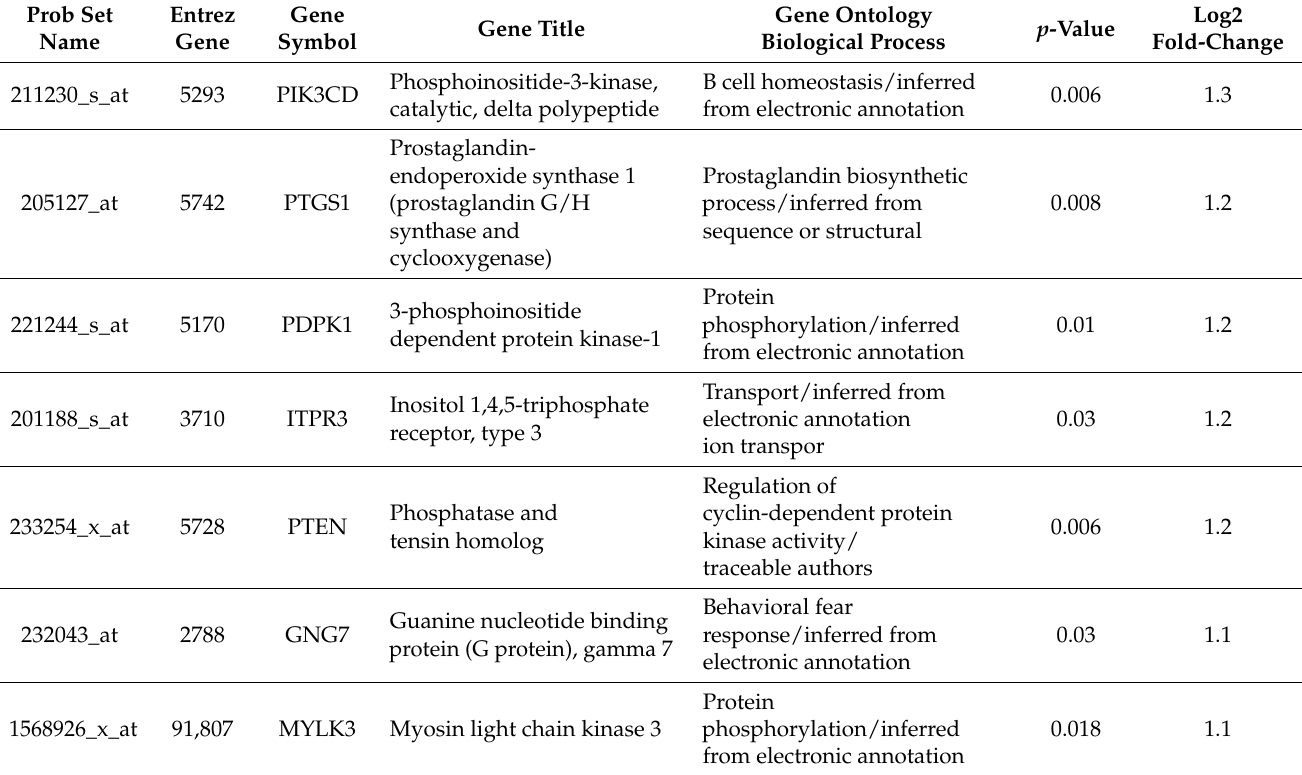
Table 7. Differential expression of 28 transcripts based on fold change annotated to genes that are involved in inflammation mediated by chemokine and cytokine signalling pathway (Low magnesium